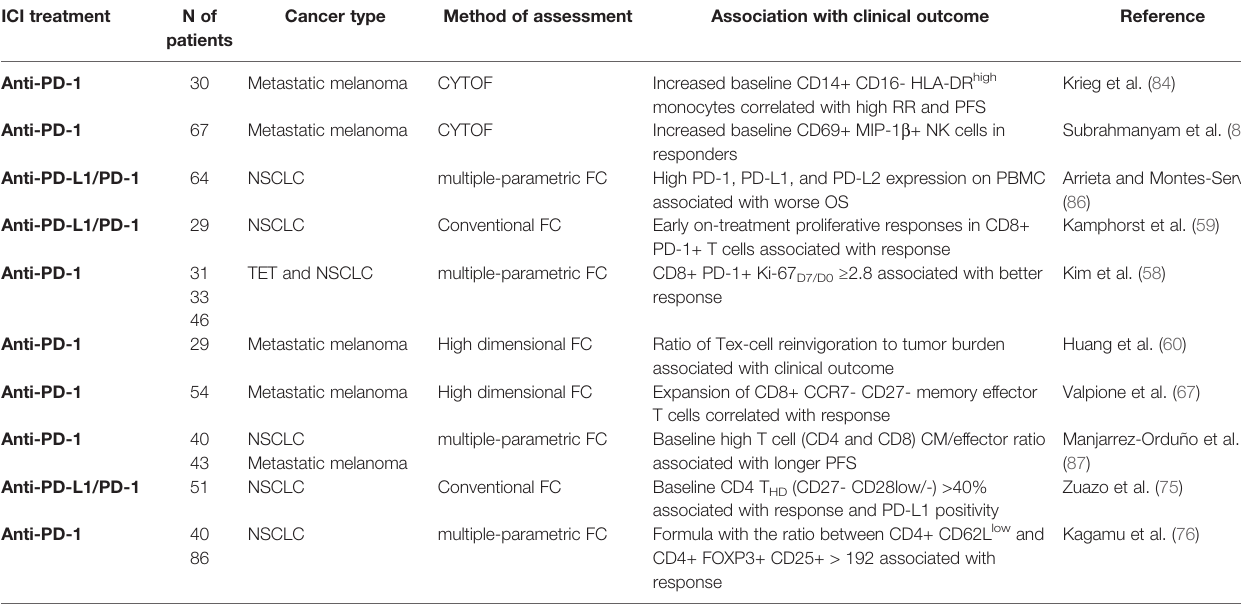
TABLE 2 | Proposed biomarkers of clinical response to PD-L1/PD-1 blockade immunotherapy based on peripheral immune cell populations. ICI